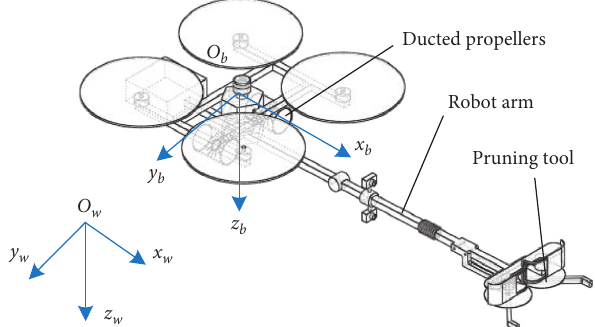
Figure 2: The world coordinate systems W and robot body coordinate system B